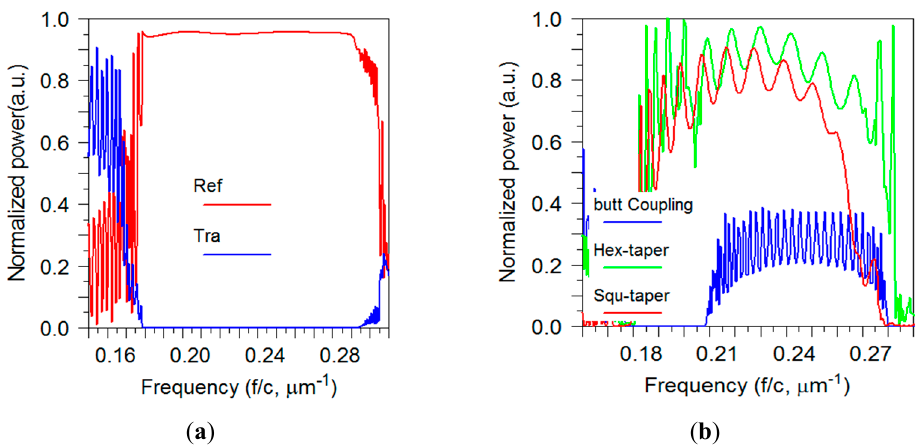
Figure 8. ( a ) Transmittance and reflectance spectrum of the PhC with hexagonal lattice calculated with FDTD method. The bandgap has a good agreement with the band structure calculated with PWE method (Figure 1a). ( b ) Transmission spectrum for the butt coupling into the PCWG (blue), the taper coupling with square lattice (red) and the taper coupling with hexagonal lattice (green).